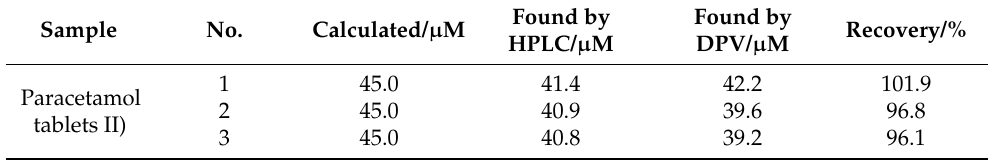
Table 2. Analytical application of paracetamol in real